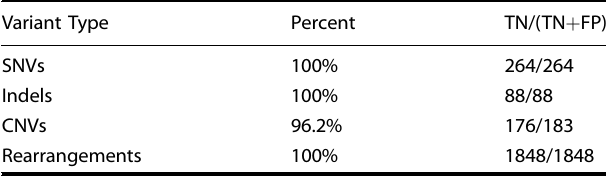
Table 2. xF analytical speci fi city. Table 3. xF accuracy compared to the Avenio ctDNA expanded